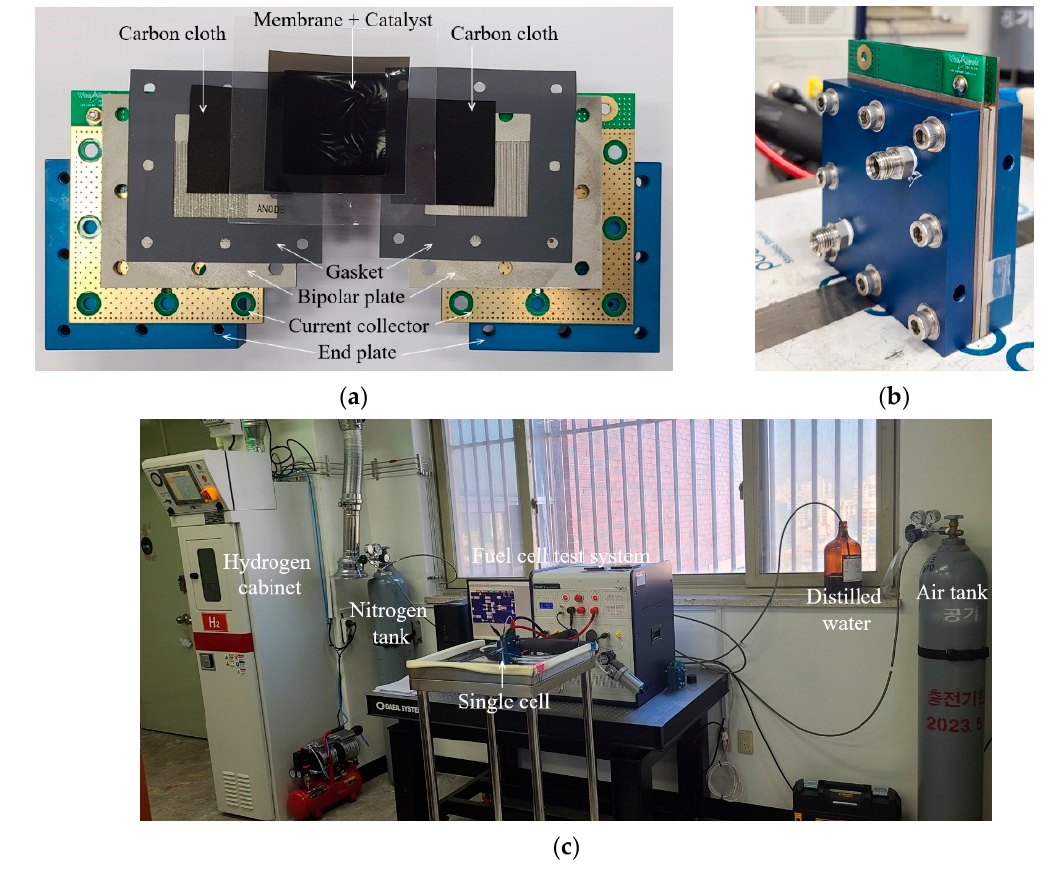
Figure 3. Fuel cell equipment: ( a ) Single-cell components; ( b ) Assembled single cell; ( c ) Fuel cell system for performance test. Table 4. MEA specification for single-cell test. Table 5. Operating condition for the single